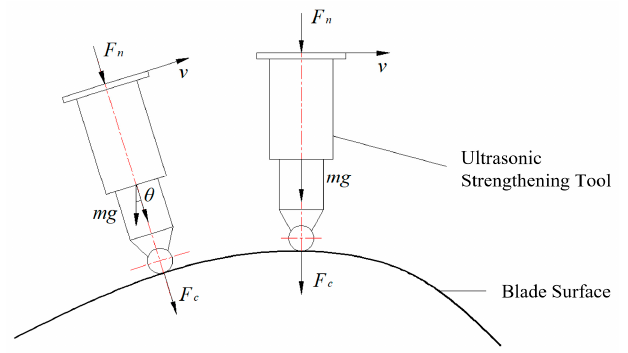
Figure 11. Force analysis of strengthening tool in the strengthening process.